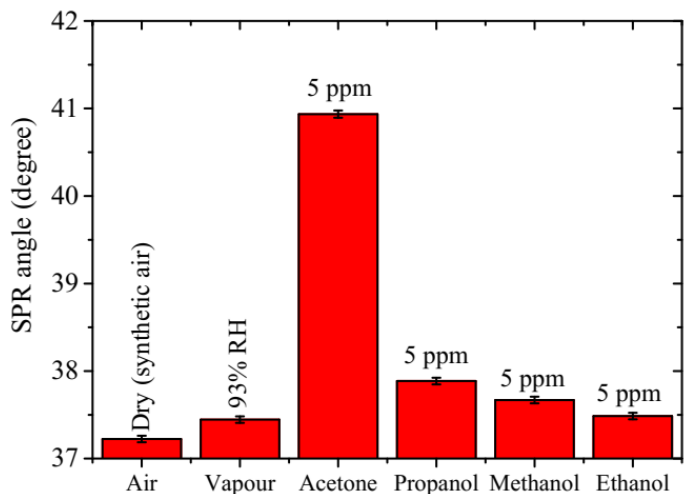
Figure 8. Selectivity of the ternary sensing layer to 5 ppm acetone vapour as compared to dry air, humid air (89% RH), and 5 ppm concentrations of propanol, methanol, and ethanol